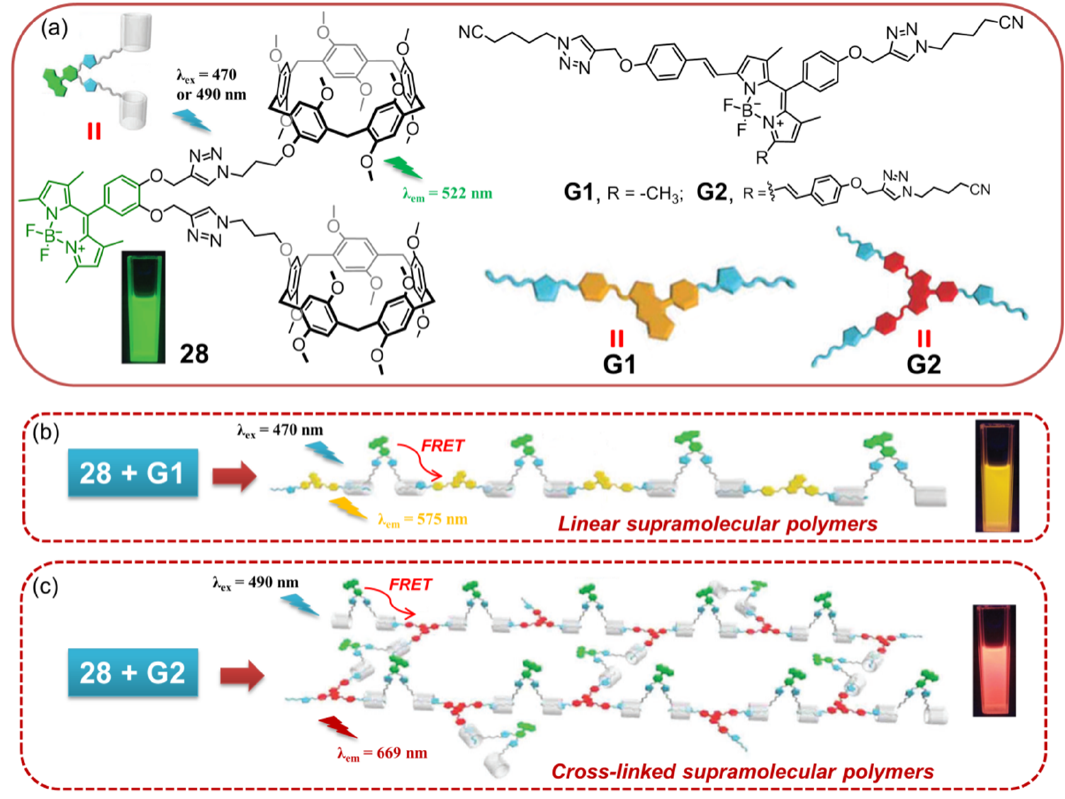
Figure 19. ( a ) Chemical structures of BODIPY-bridged pillar[5]arene dimer 28 and two BODIPY derivative guests G1 and G2 ; construction of fluorescence resonance energy transfer (FRET)-capable ( b ) linear and ( c ) cross-linked supramolecular polymers based on 28 with G1 and G2 , respectively. Reproduced with permission from Reference [103]. Copyright 2015 Royal Society of Chemistry.